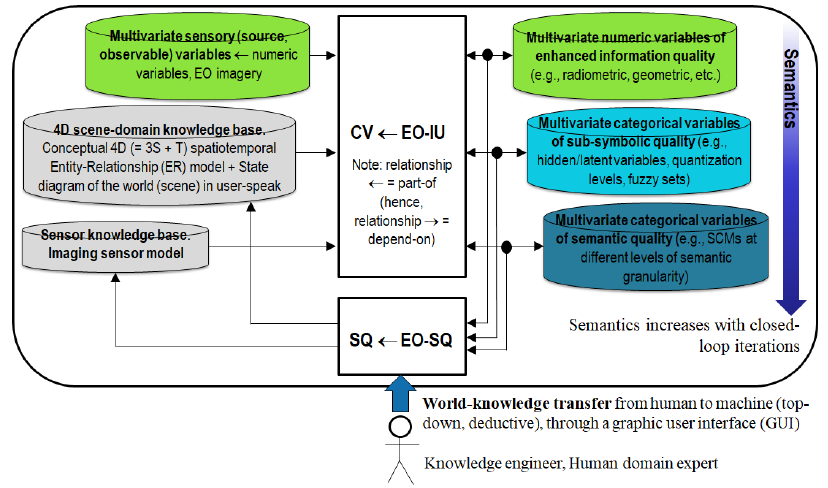
Figure 5. Artificial intelligence (AI) for data and information access services (AI4DIAS), synonym for semantics-enabled DIAS or closed-loop EO image understanding (EO-IU) for semantic querying (EO-IU4SQ) system architecture. At the Marr level of system understanding known as system design (architecture) [76], AI4DIAS is sketched as a closed-loop EO-IU4SQ system architecture, suitable for incremental semantic learning. It comprises a primary (dominant, necessary-but-not-sufficient) hybrid (combined deductive and inductive) feedback (provided with feedback loops) EO-IU subsystem in closed-loop with a secondary (dominated) hybrid feedback EO-SQ subsystem.